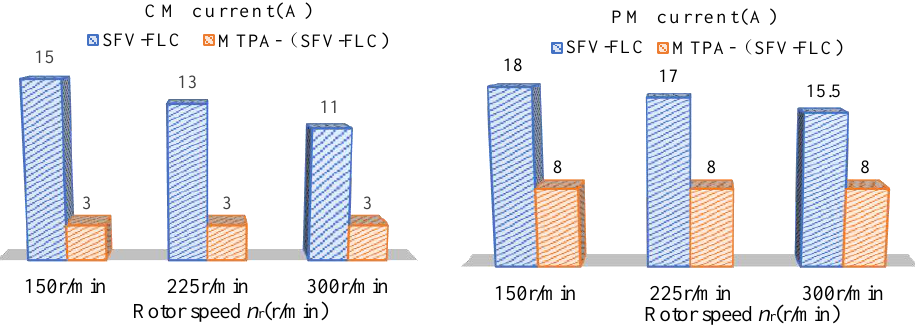
Table 2. Current comparison between the two control methods of MTPA-(SFV-FLC) and (SFV-FLC) when the speed changes.